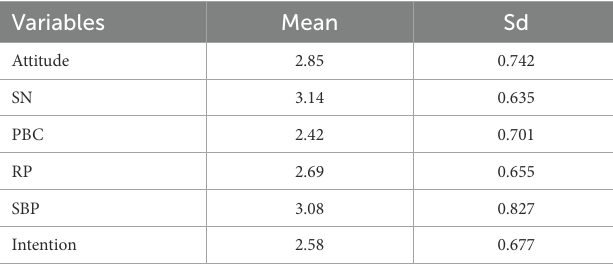
TABLE 2 The status of research variables.